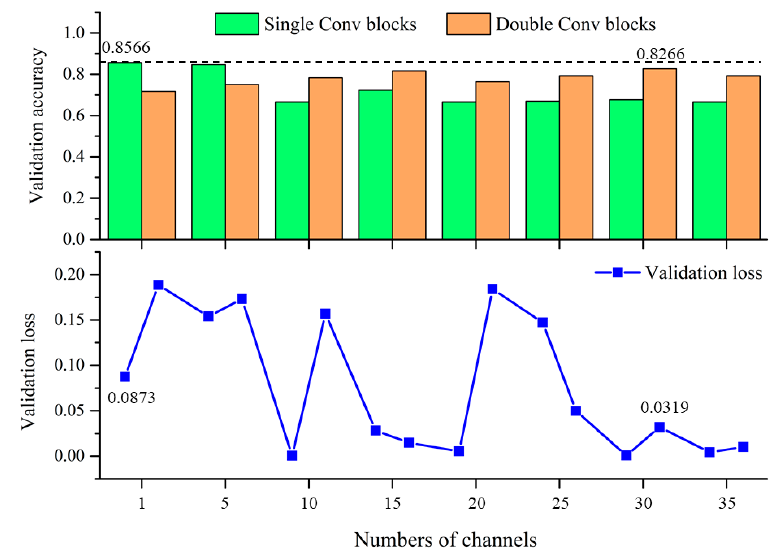
Figure 11. Validation performance of 2D-CNN with different network structures.